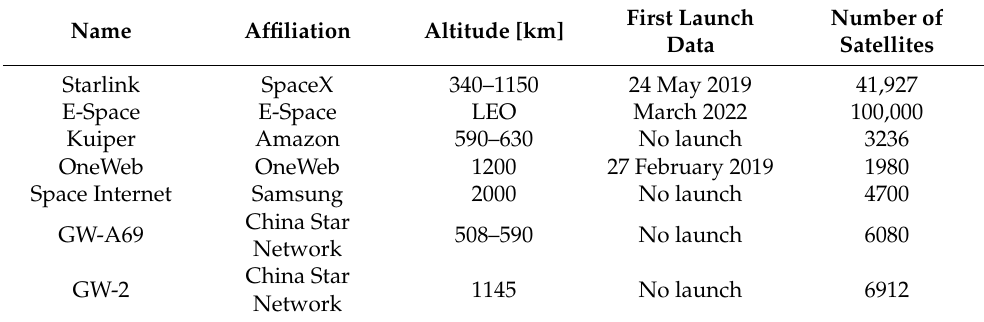
Table 1. Major international mega constellation programs